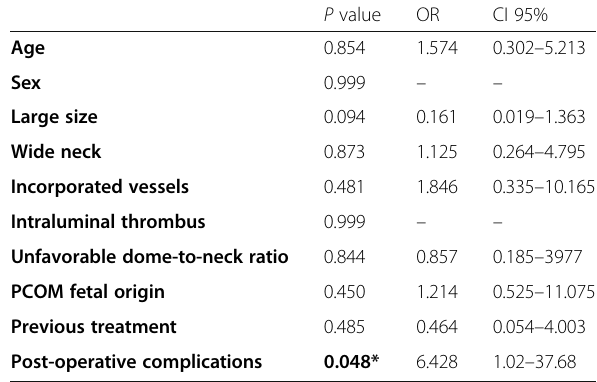
Table 3 Univariate logistic regression of predictors of